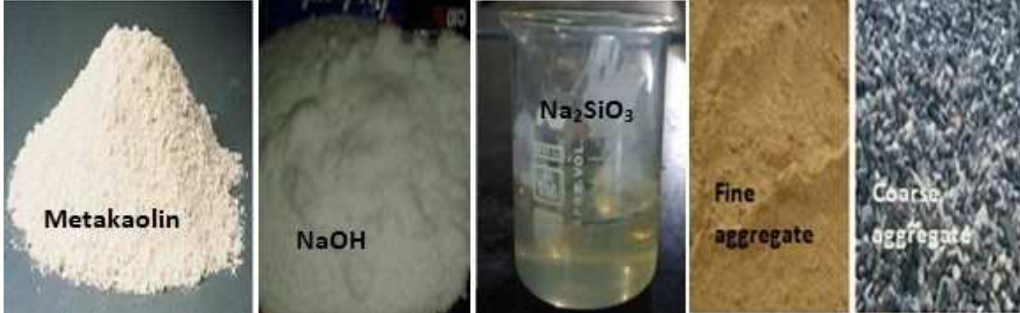
Figure 4. Materials used in production of metakaolin-based geopolymer concrete.